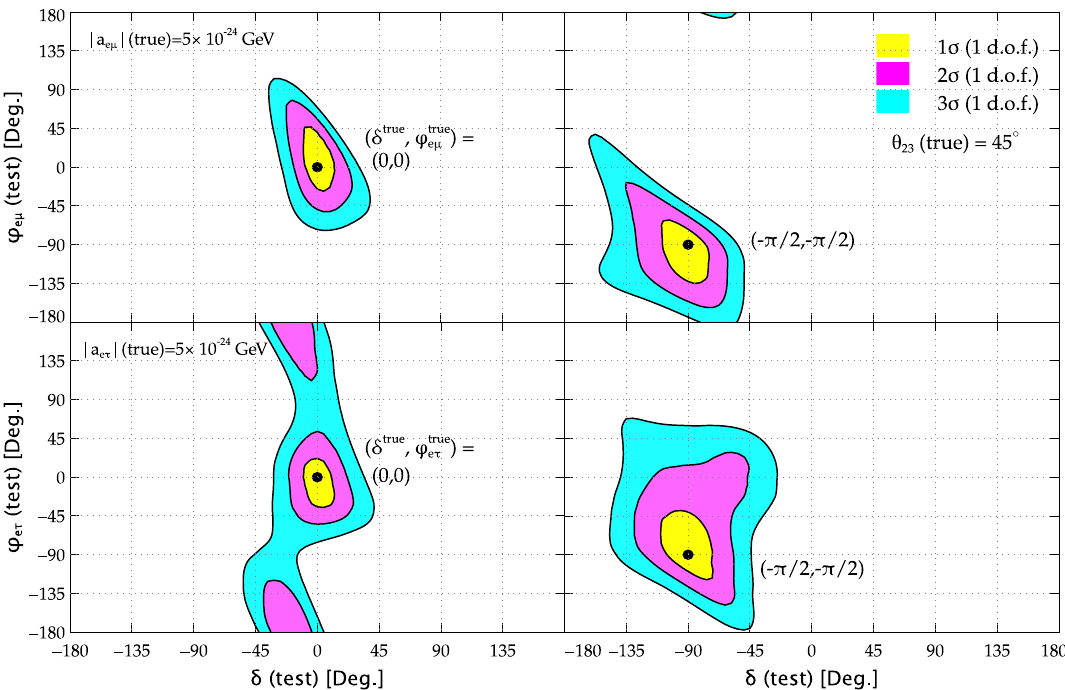
Fig. 8 ReconstructedregionsforthetwoCPphases δ and ϕ e μ (toppan- els) at 1 σ , 2 σ , and 3 σ (1 d.o.f.) confidence levels assuming NO both in data and theory. The bottom panels show the same for the two CP phases δ and ϕ e τ . The two left (right) panels refer to the representative true values of the phases [0, 0] ([ − π/ 2 , − π/ 2]). In all the panels, the